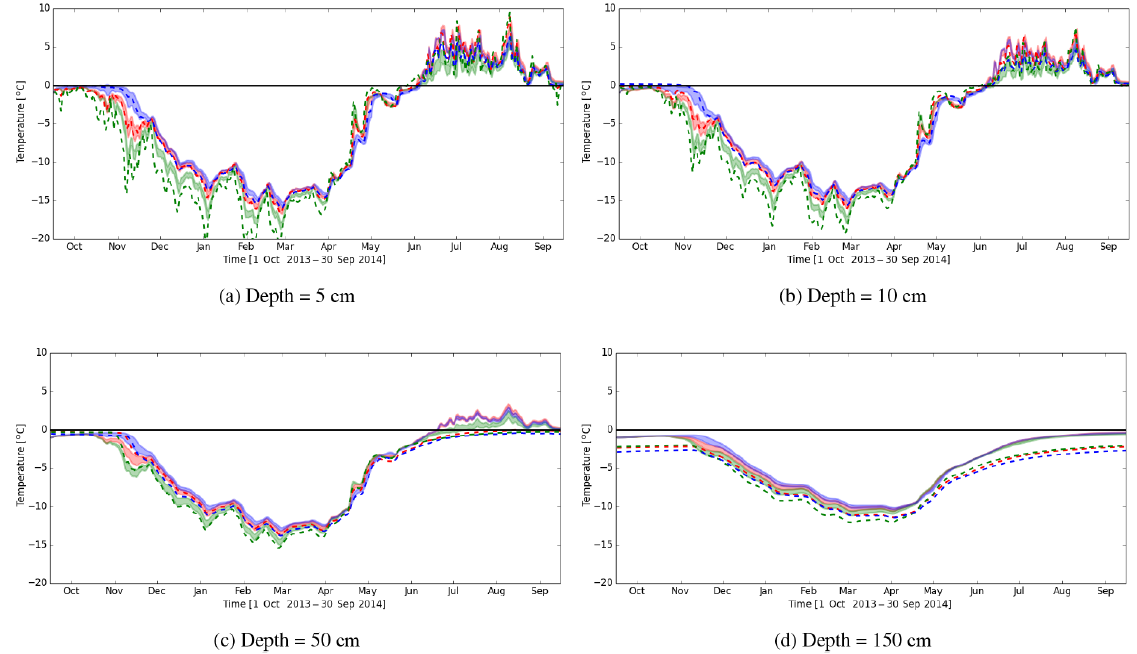
Figure 9. Simulated vs. observed soil temperatures at Site C at depths 5, 10, 50 and 150cm show bias in the model in deeper soil and during the warm summer season. Dotted lines represent observed data at center (in red), rim (green) and trough (blue) locations, while shaded curves show mean ± standard deviation of simulated daily soil temperatures across the